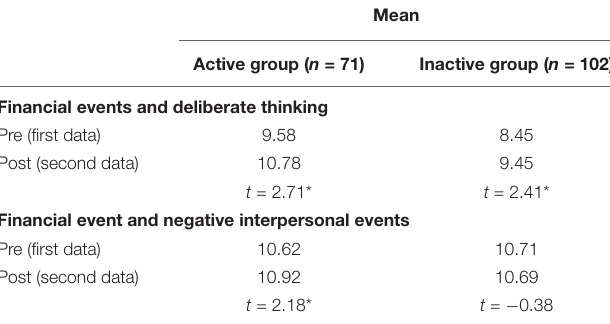
TABLE 3 | T -test results of financial events, deliberate thinking, and negative interpersonal